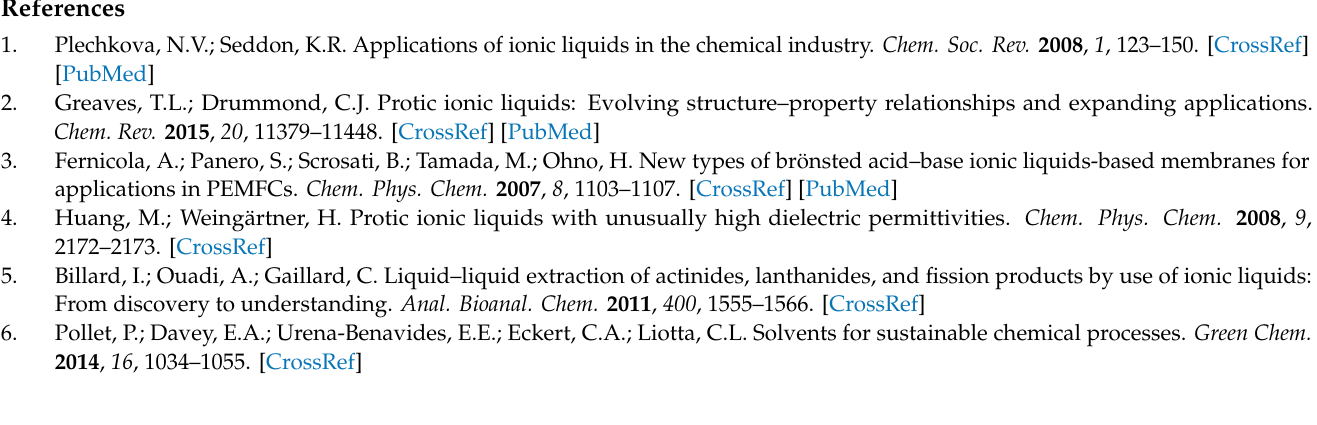
in water. Figure S9. (a) The increasing absorbance during the deprotonation of the acid indicator (4- nitrophenol) by the base. (b) The decreasing absorbance of the acid indicator anion (4-nitrophenolate) during the titration of [D-PheC 1 ]Cl in water. Figure S10. (a) The increasing absorbance during the deprotonation of the acid indicator (4-nitrophenol) by the base. (b) The decreasing absorbance of the acid indicator anion (4-nitrophenolate) during the titration of [D-PheC 1 ]NO 3 in water. Figure S11. (a) The increasing absorbance during the deprotonation of the acid indicator (4-nitrophenol) by the base. (b) The decreasing absorbance of the acid indicator anion (4-nitrophenolate) during the titration of [PheC 1 ]NTf 2 in water. Figure S12. (a) The increasing absorbance during the deprotonation of the acid indicator (4-nitrophenol) by the base. (b) The decreasing absorbance of the acid indicator anion (4-nitrophenolate) during the titration of [PheC 1 ]ClO 4 in water. Figure S13. (a) The increasing absorbance during the deprotonation of the acid indicator (2,4-dinitrophenol) by the base. (b) The decreasing absorbance of the acid indicator anion (2,4-dinitrophenolate) during the titration of [GlyC 1 ]NO 3 in ethanol. Figure S14. (a) The increasing absorbance during the deprotonation of the acid indicator (2,4-dinitrophenol) by the base. (b) The decreasing absorbance of the acid indicator anion (2,4-dinitrophenolate) during the titration of [ValC 1 ]NO3 in ethanol. Figure S15. (a) The increasing absorbance during the deprotonation of the acid indicator (2,4-dinitrophenol) by the base. (b) The decreasing absorbance of the acid indicator anion (2,4-dinitrophenolate) during the titration of [SerC 1 ]NO 3 in ethanol. Figure S16. (a) The increasing absorbance during the deprotonation of the acid indicator (2,4-dinitrophenol) by the base. (b) The decreasing absorbance of the acid indicator anion (2,4-dinitrophenolate) during the titration of [PheC 1 ]NO 3 in ethanol. Figure S17. (a) The increasing absorbance during the deprotonation of the acid indicator (2,4-dinitrophenol) by the base. (b) The decreasing absorbance of the acid indicator anion (2,4-dinitrophenolate) during the titration of [PheC 2 ]NO 3 in ethanol. Figure S18. (a) The increasing absorbance during the deprotonation of the acid indicator (2,4-dinitrophenol) by the base. (b) The decreasing absorbance of the acid indicator anion (2,4-dinitrophenolate) during the titration of [D-PheC 1 ]NO 3 in ethanol. Figure S18. (a) The increasing absorbance during the deprotonation of the acid indicator (2,4-dinitrophenol) by the base. (b) The decreasing absorbance of the acid indicator anion (2,4-dinitrophenolate) during the titration of [PheC 1 ]NTf 2 in ethanol. Optimized geometry